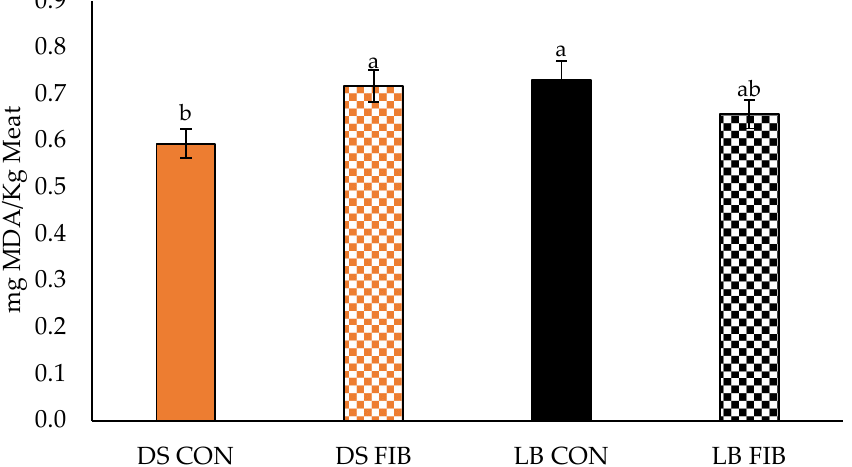
Figure 6. Effect of breed × diet interaction for the lipid oxidation (TBARS value) of sausage patties. DS = Duroc-sired and LB = Large Black pigs. CON = diet of corn–soybean meal, DDGS-based; FIB = diet using increasing amounts of wheat middlings (1–10%) and dehydrated alfalfa meal (7.5–20%) to replace corn and soybean meal in the CON diet. DS = Duroc sired and LB = Large Black pigs. ab Means lacking a common superscript within the main effect of breed or diet differ ( p < 0.05).